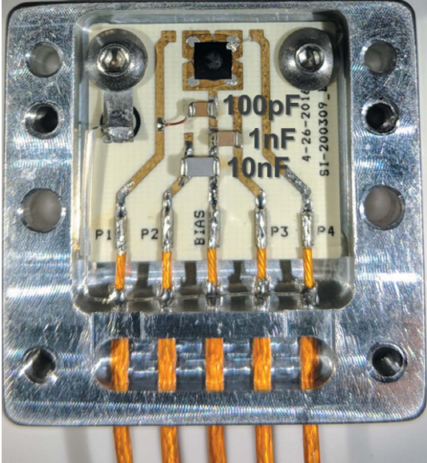
Figure 1 Photograph of the Sydor assembly, with the upper shielding cover removed. The signal readout trace is at the right (P4) and the supply bypass through the 10 nF capacitor was established by connecting trace P2 to ground through the attached RG316 coaxial cable. The sensor is at the top-centre of the assembly and is connected to the readout trace via an array of wire